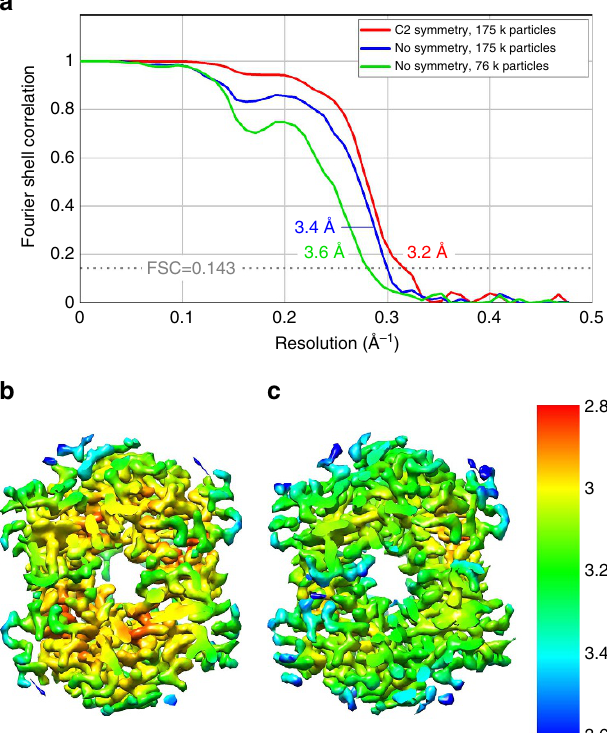
Figure 3 | Resolution estimation. ( a ) Fourier shell correlation (FSC) plots indicating resolutions of 3.2Å for the C2 symmetry (red line), 3.4Å for the asymmetric (blue line) and 3.6Å for the subset asymmetric (green line) reconstructions according to the FSC ¼ 0.143 criterion. ( b ) Local resolution estimation of the C2 symmetry map. ( c ) Local resolution estimation of the asymmetric